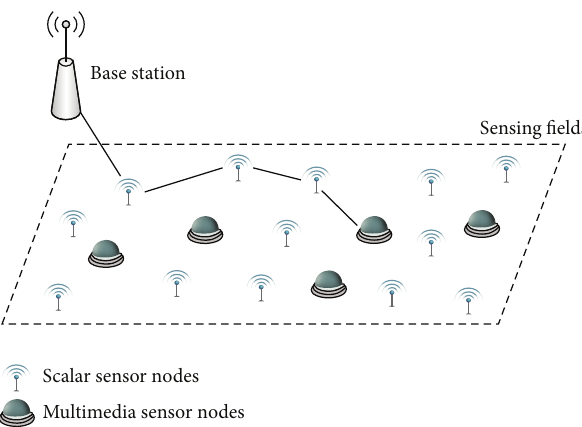
Figure 1: Deployment of wireless multimedia sensor